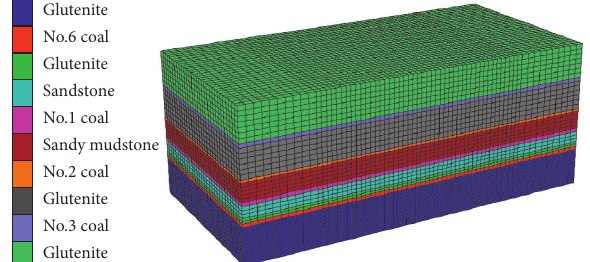
Figure 12: Three-dimensional numerical model of coal